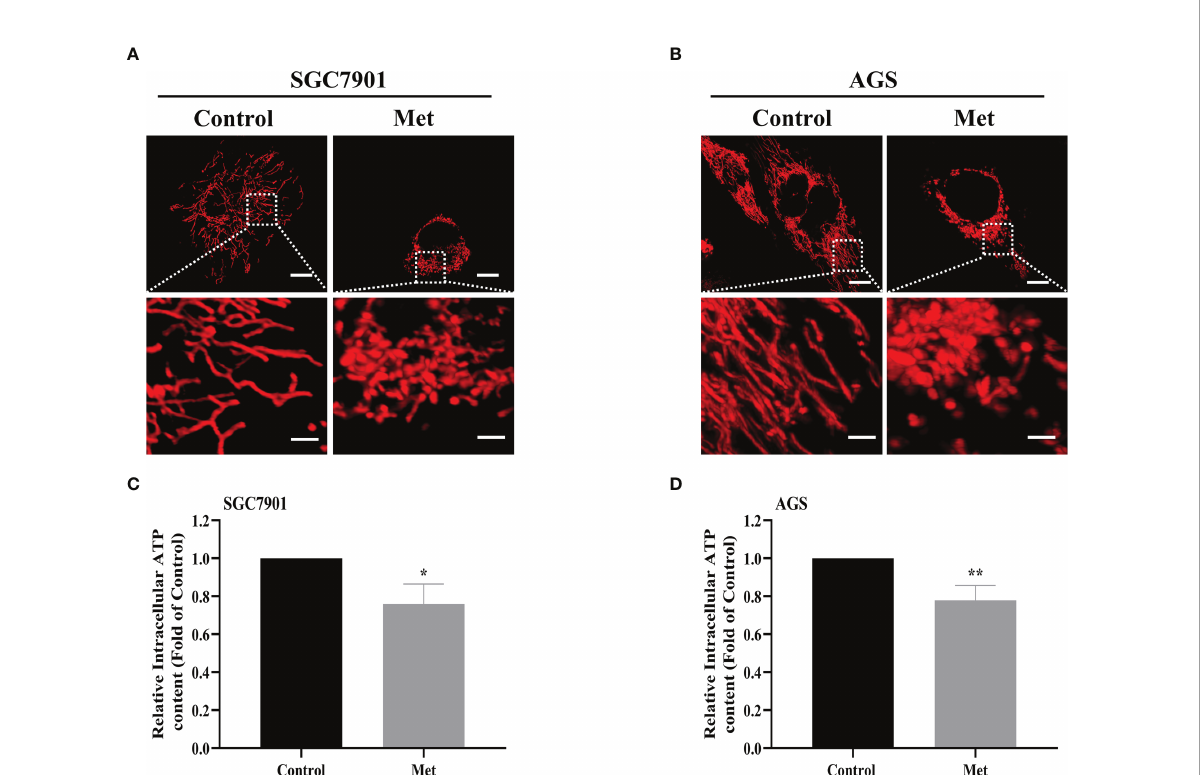
FIGURE 6 Metformin stimulated mitochondrial fi ssion and decreased the intracellular ATP level in GC cells. (A, B) Mitochondrial morphology was shown. SGC7901 and AGS cells were transfected with pDsRed2-Mito and treated with or without 10 mM metformin for 24 h. Scale bar=10 µm. Circled images at higher magni fi cation are shown in the below panels, scale bar=2 µm. (C, D) SGC7901 and AGS cells were incubated with 10 mM metformin for 24 h, then ATP levels were detected by ATP assay kit. Data were presented as the means ± SD. The experiments were repeated three times independently. * p <0.05; ** p